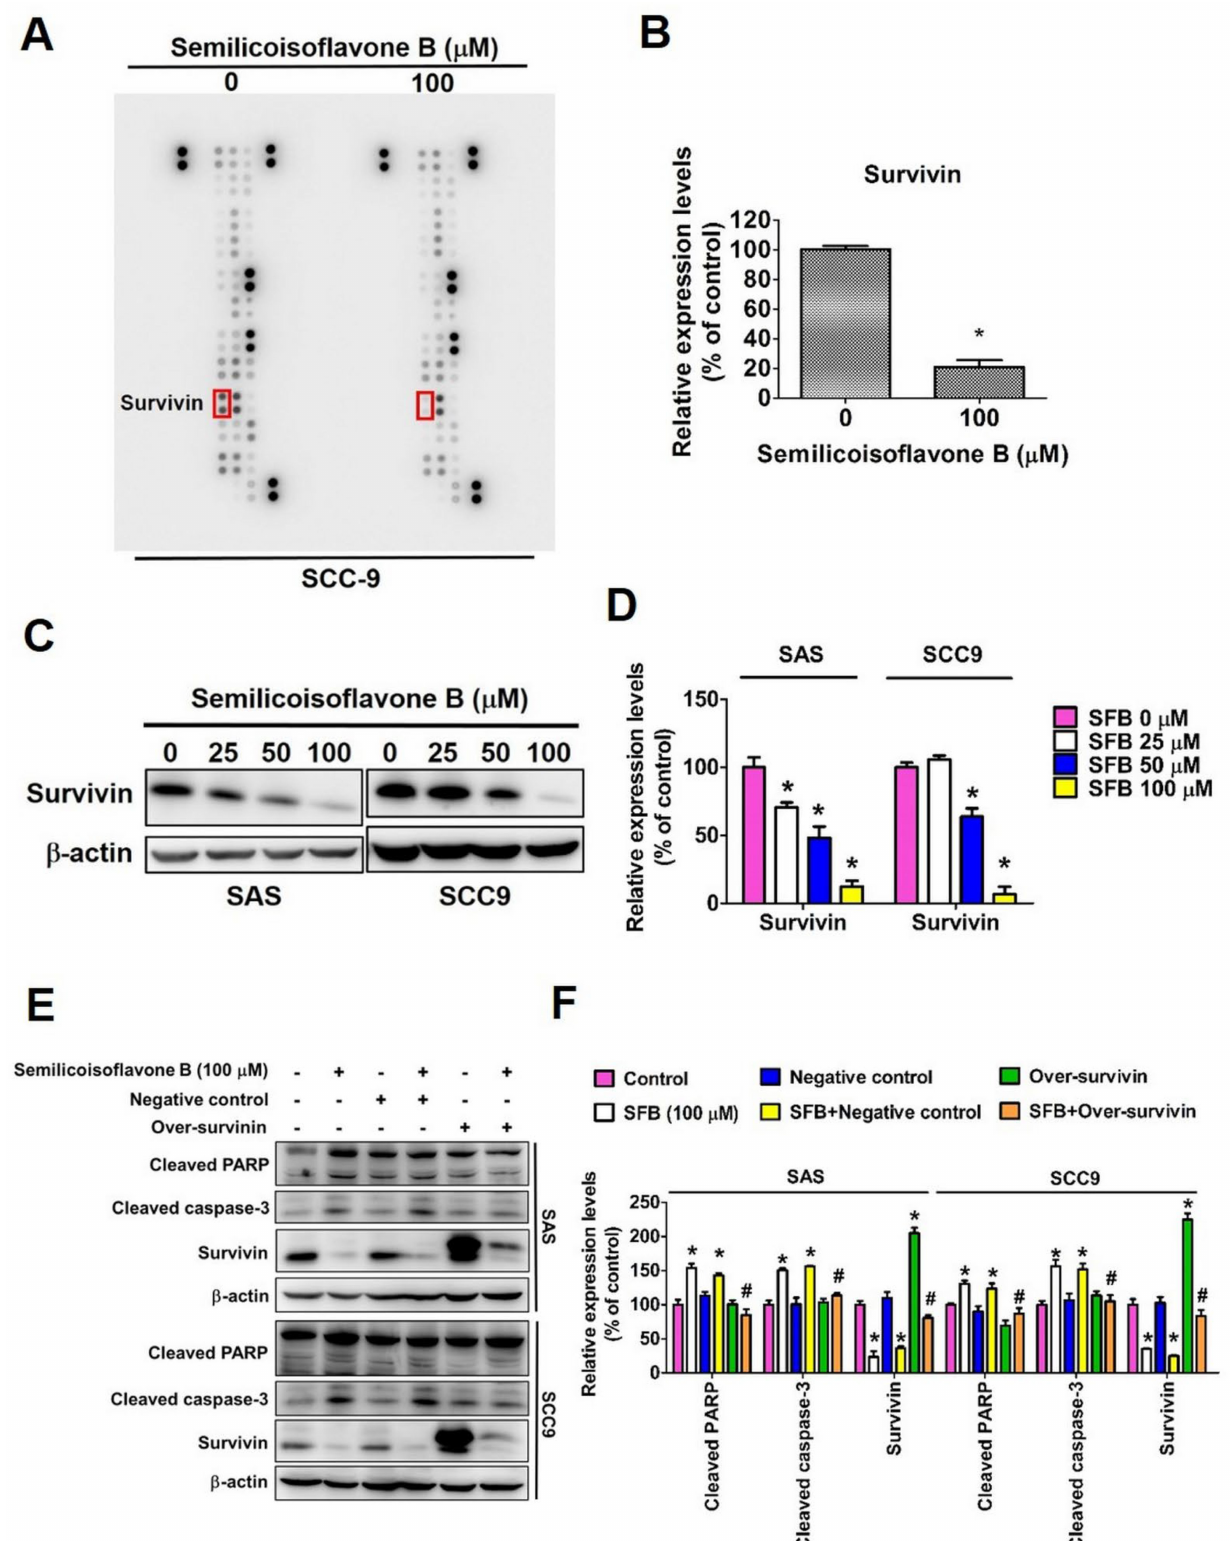
Figure 7. Survivin plays a crucial rule in semilicoisoflavone B-induced antiproliferation and PARP activation. ( A ) After treatment of 100 µ M SFB for 24 h in SCC-9 cells, the human apoptosis ar- ray (ARY009, R&D systems) were employed and the decreased survivin protein was exposed to quantitative analysis. ( B ) Intensity qualifications of survivin in SFB-treated SCC-9 cells. ( C ) SAS